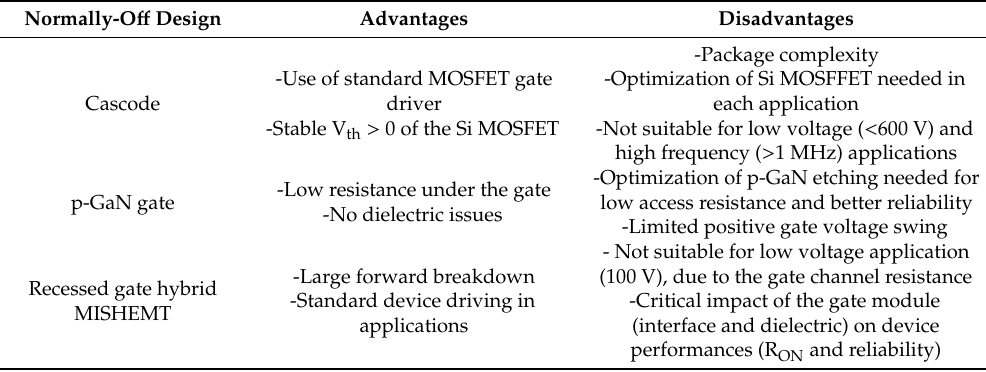
Table 4. Advantages and disadvantages of the three main normally-o ff GaN HEMT solutions in terms of processing and performances: “cascode” configuration, p-GaN gate and recessed gate hybrid